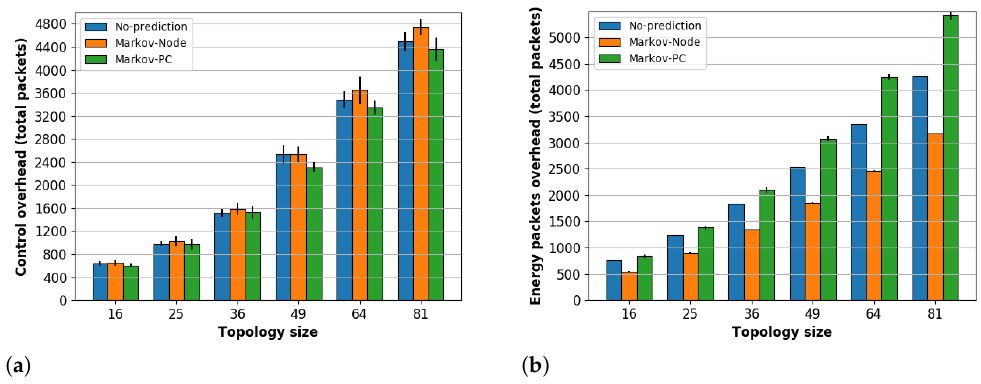
Figure 6. Packets overhead of Markov chain and No-Prediction schemes: ( a ) shows the number of control packets and ( b ) shows the number of energy